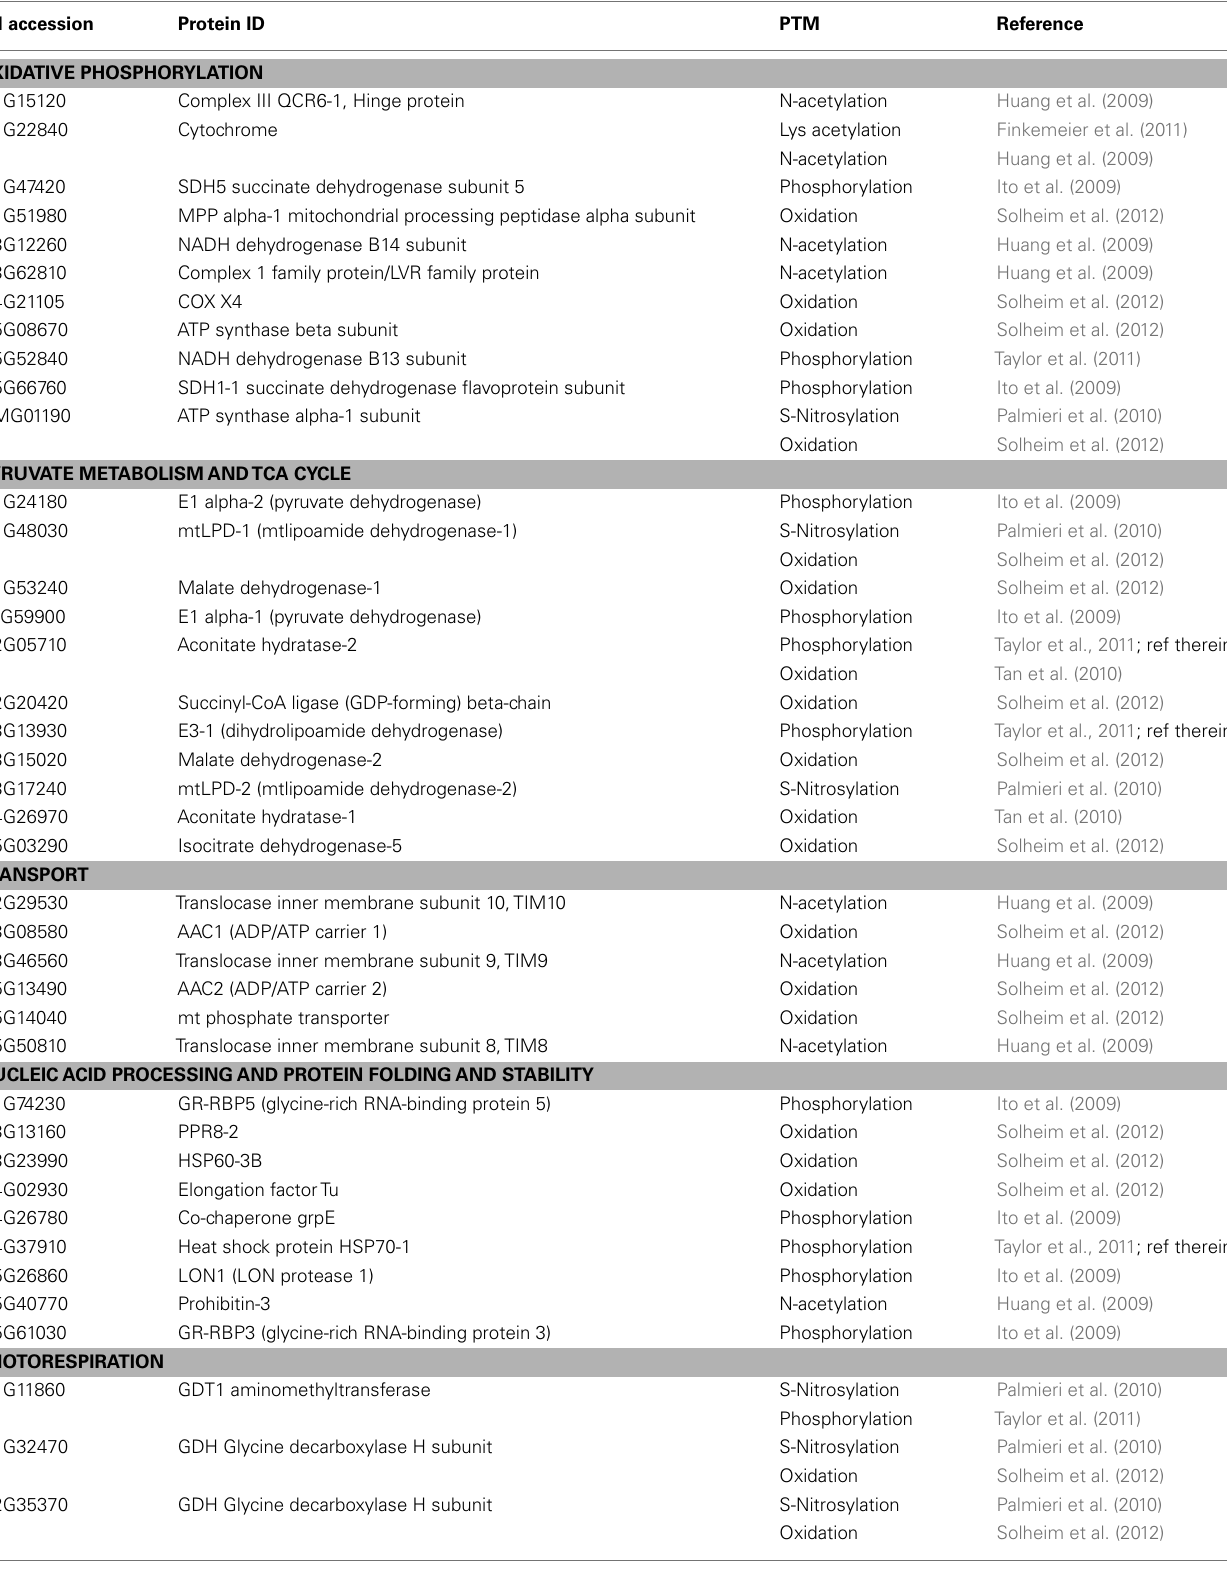
Table 1 |The set of mitochondrial proteins in Arabidopsis with known post-translational